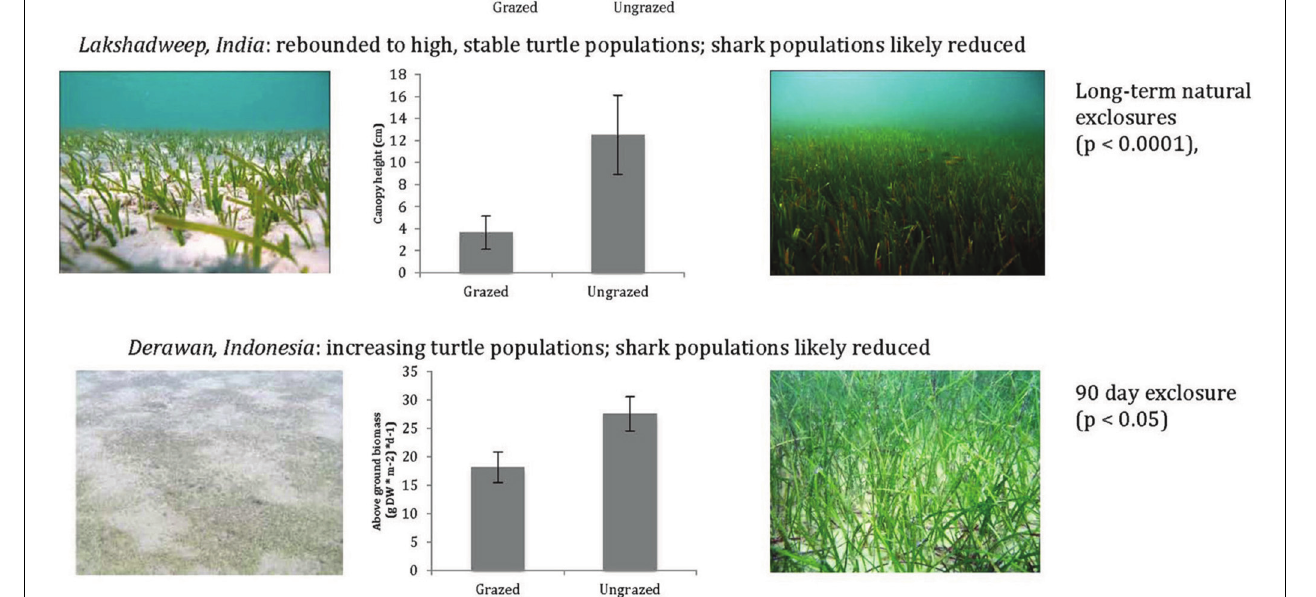
high probability of green turtle predation by tiger sharks, and low risk habitats are relatively safe havens for the turtles (Heithaus et al., 2007). Details of other responses can be found in companion publications (Fourqurean et al., 2010; Lal et al., 2010; Christianen et al., 2012, 2014; Burkholder et al.,